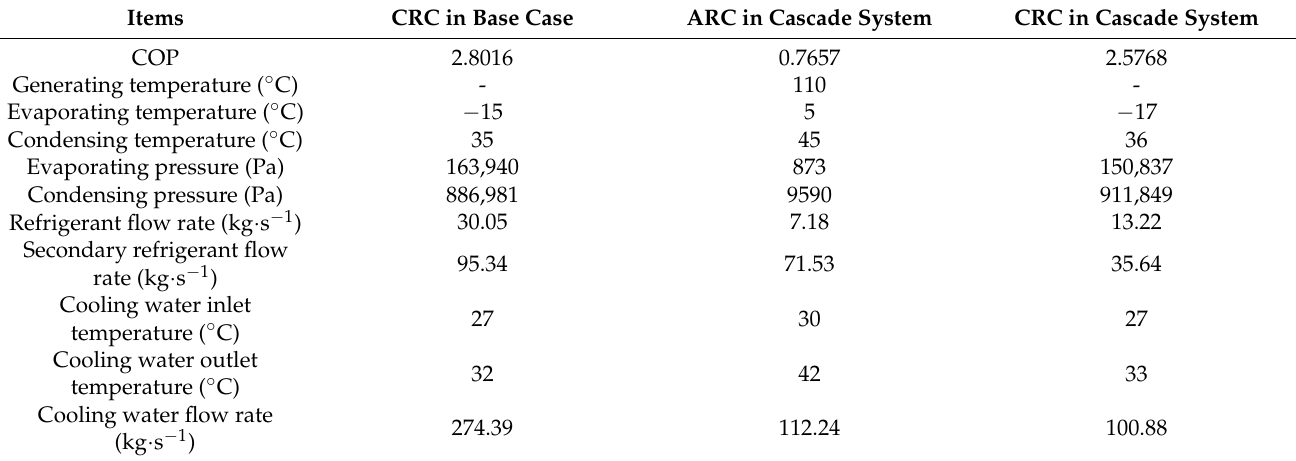
Table 6. Parameters of the refrigeration